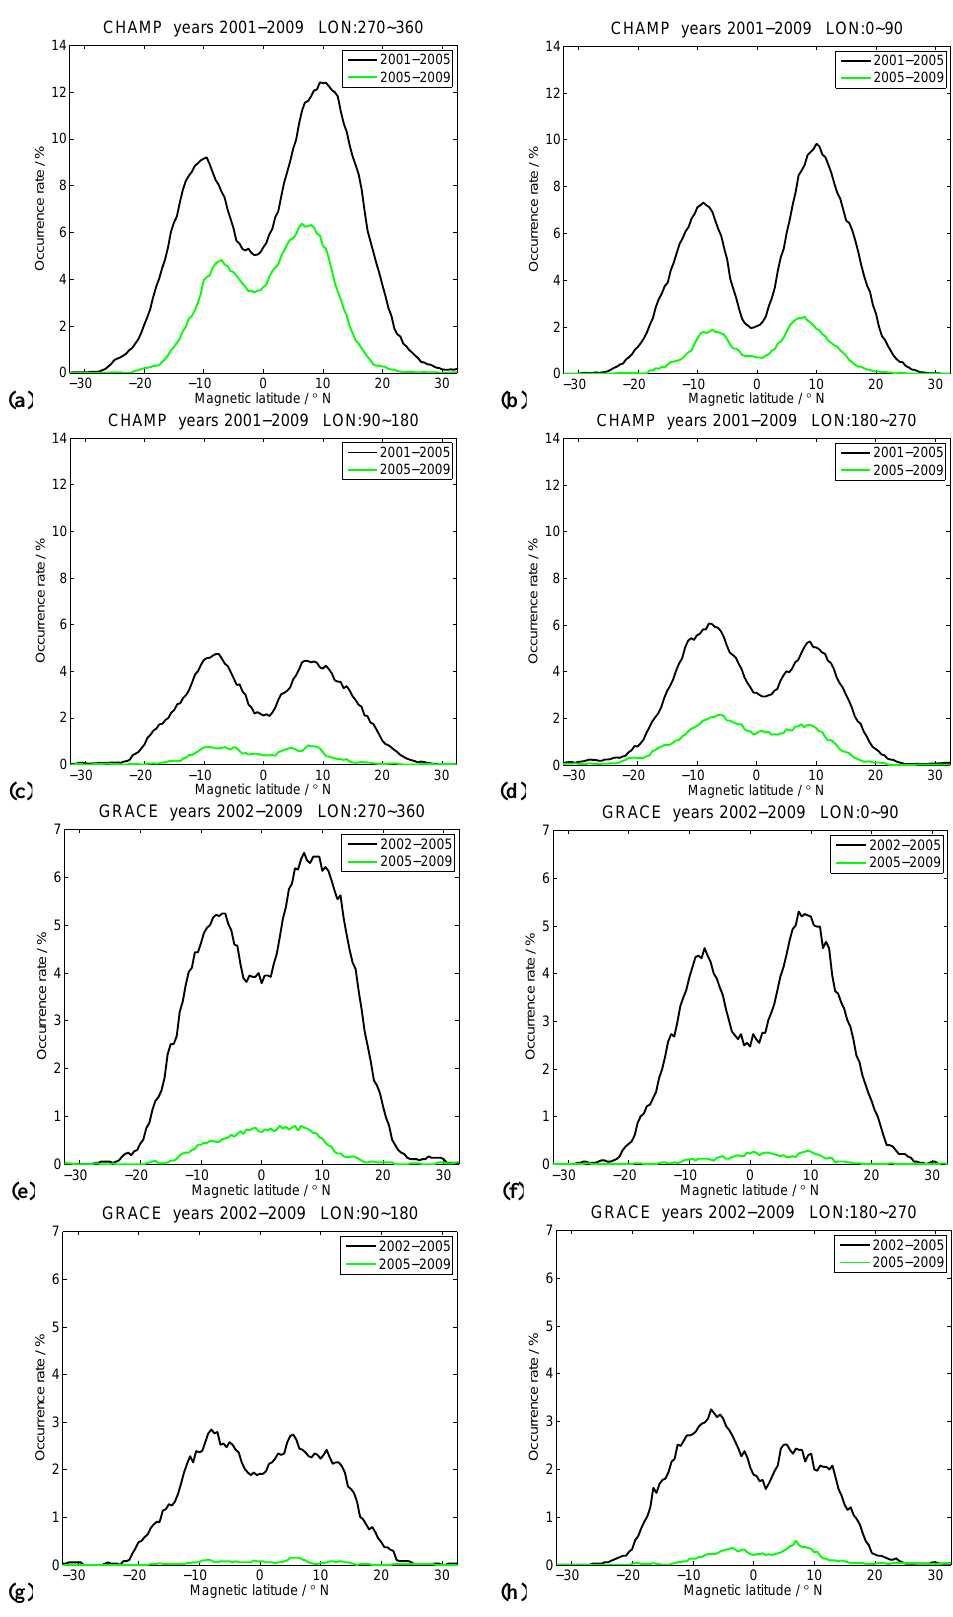
Fig. 11. Same format as Fig. 9, but separate latitude profiles for four longitude